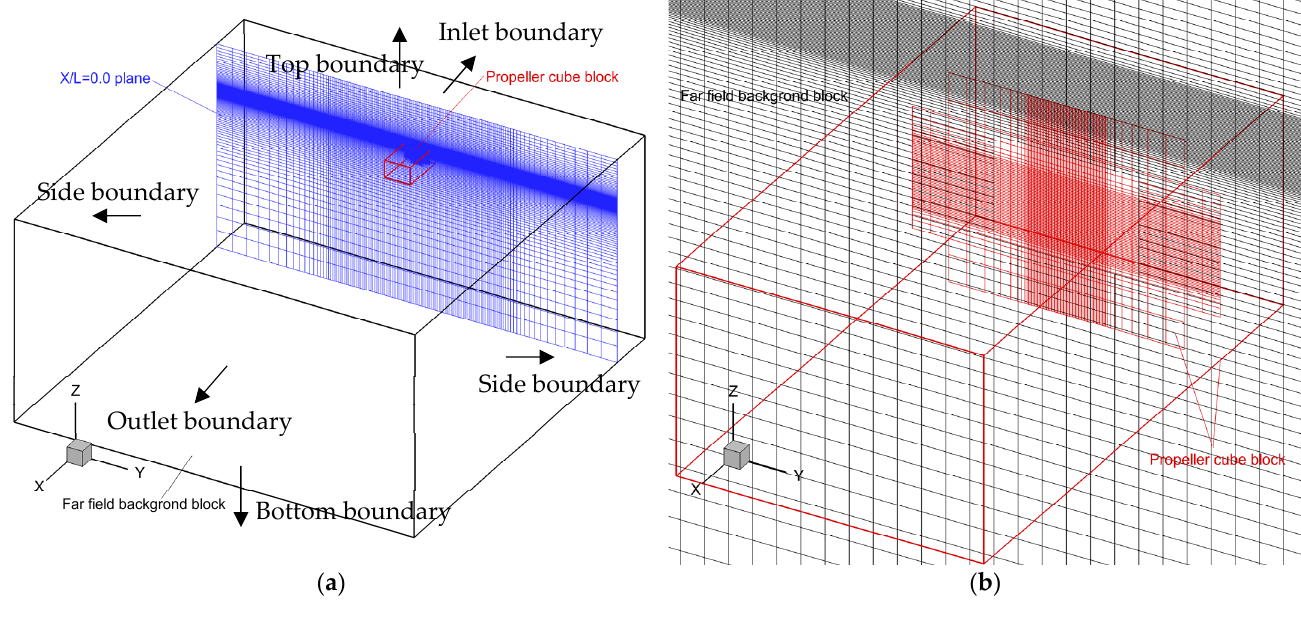
Figure 4. Overset grid system for the open water propeller (the grids are plotted on propeller plane at x/L = 0): ( a ) far view; ( b ) near view. Table 1. Grid size ( N i , N j , N k are the grid number in the x , y , z direction, respectively).